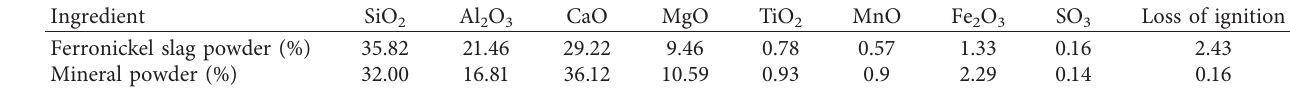
Table 3: The chemical composition of the ferronickel slag powder and mineral powder.